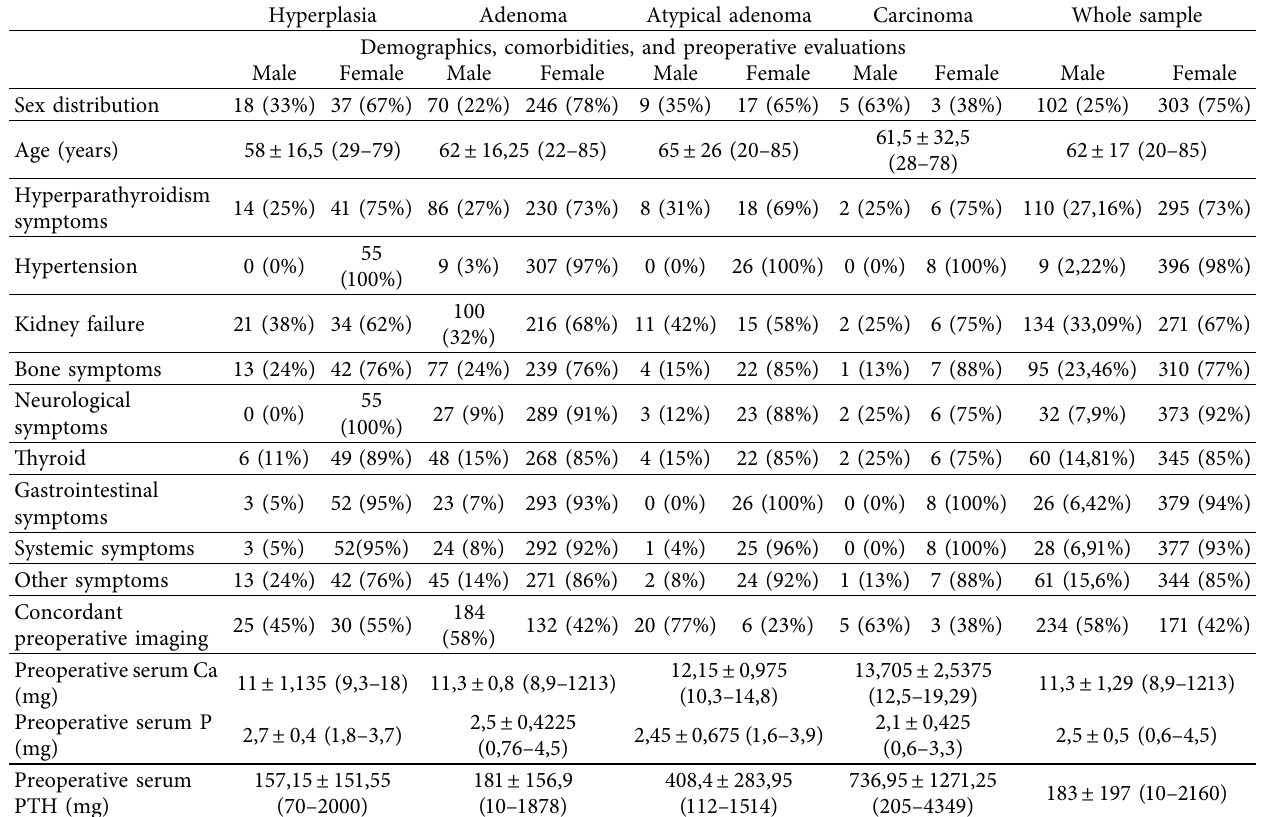
Table 5: Patients’ characteristics according to final histology.